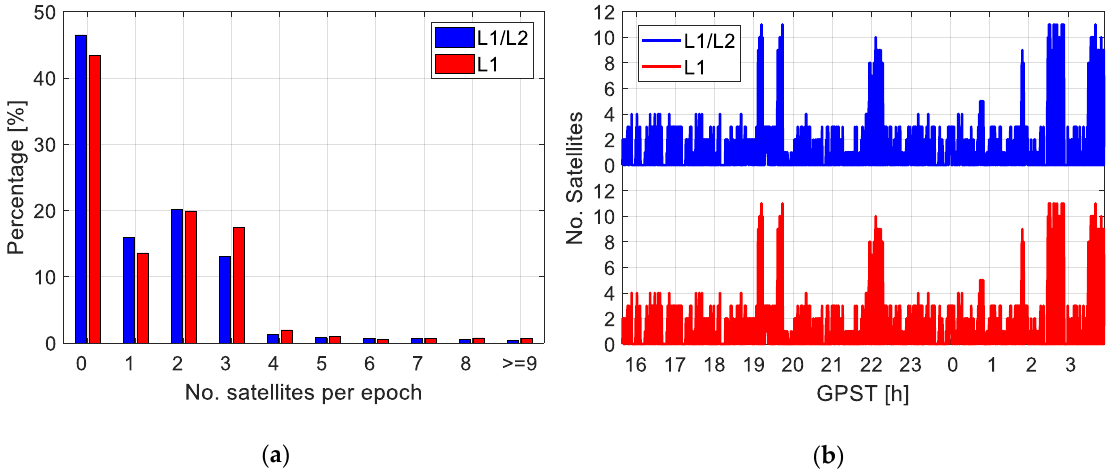
Figure 1. ( a ) Distribution of the tracked satellite numbers per epoch and ( b ) the time history of the satellite numbers having both the L1 / L2 observations and at least the L1 observations. The data was collected from the CubeSat STF-1 from 15:39:37 in GPS time (GPST) on 27 February 2019 to 3:55:10 on 28 February 2019.